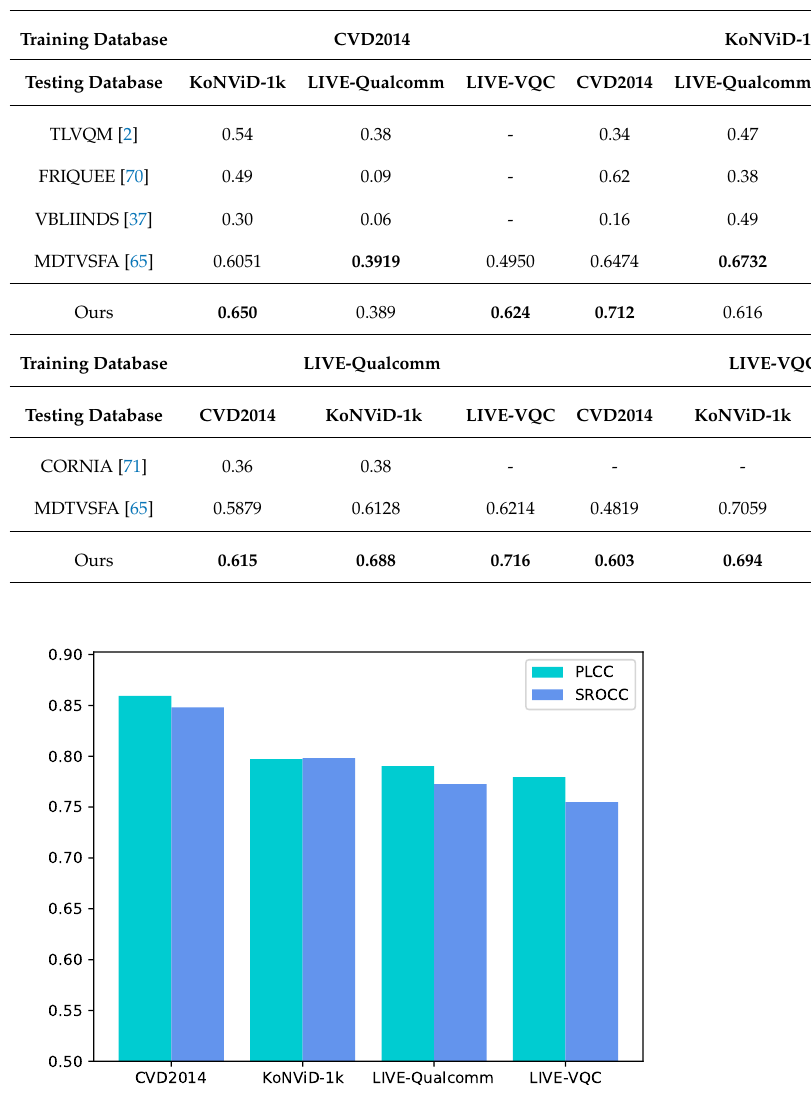
Table 3. Performance of the cross-dataset quality evaluation. The largest values marked in bold stand for the best results. The results of FRIQUEE, VBLIINDS, CRONIA, and TLVQM reported in [2] are shown here for reference.